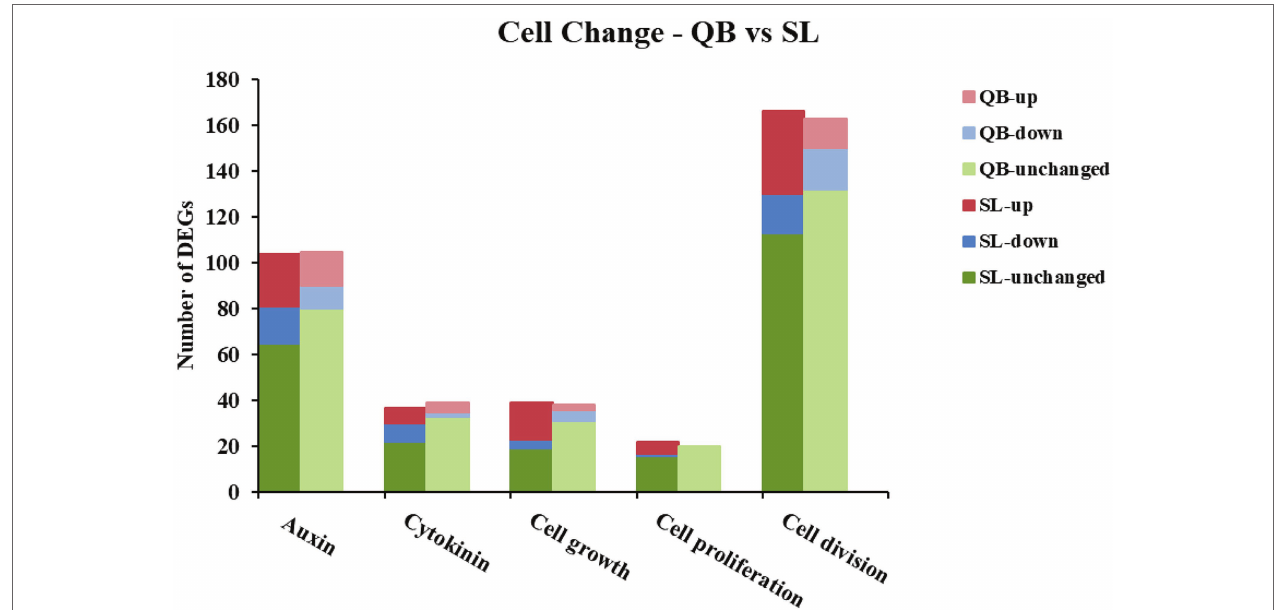
FIGURE 11 | Statistics of genes associated with cell changes in Swan Lake (SL) and Qingdao Bay